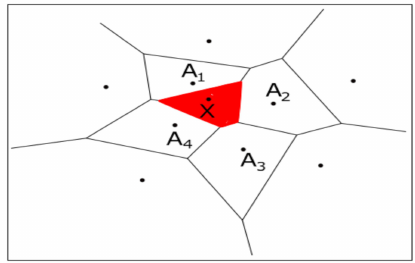
Figure 7. Nearest Neighbour grid where estimation in the X is done regarding to points A 1 –A 4 (e.g.,